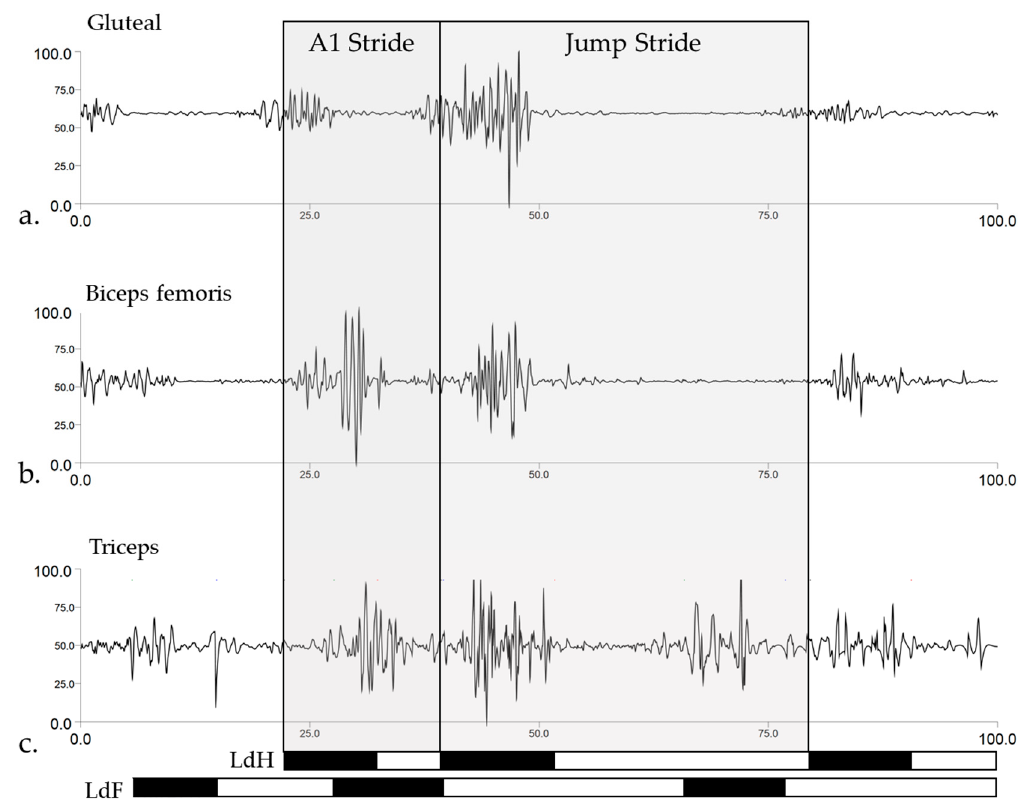
Figure 5. Phasic activity patterns of ( a ) gluteal, ( b ) biceps femoris, and ( c ) triceps muscles from a representative Intermediate CM horse and jump trial. Approach (A1) stride and jump stride are labelled and illustrated as grey shaded boxes. sEMG signals are direct current (DC)-offset removed and high-pass filtered (Butterworth 4th order, 40 Hz cut-off frequency). Bottom bars represent stance (black shaded areas) and swing (white shaded areas) phases for the right hindlimb and forelimb that acted as leading hindlimb (LdH) and leading forelimb (LdF), respectively, during this jump trial.